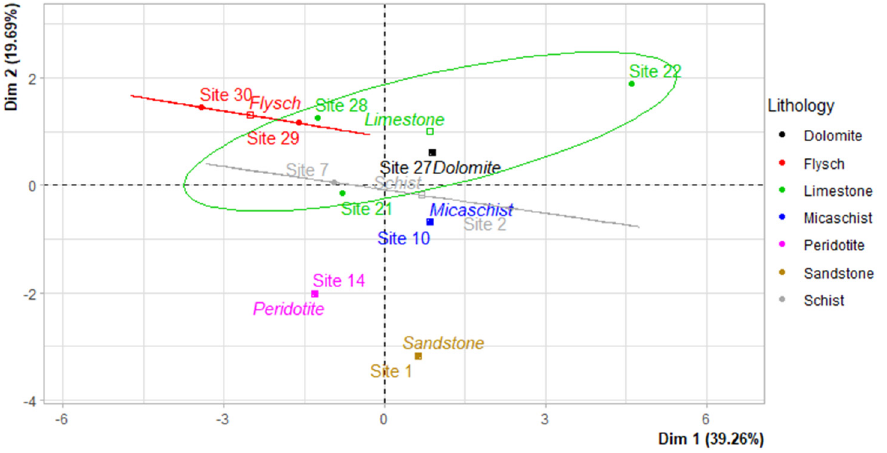
Figure 15. Representation of the study sites according to “ Lithology ”.